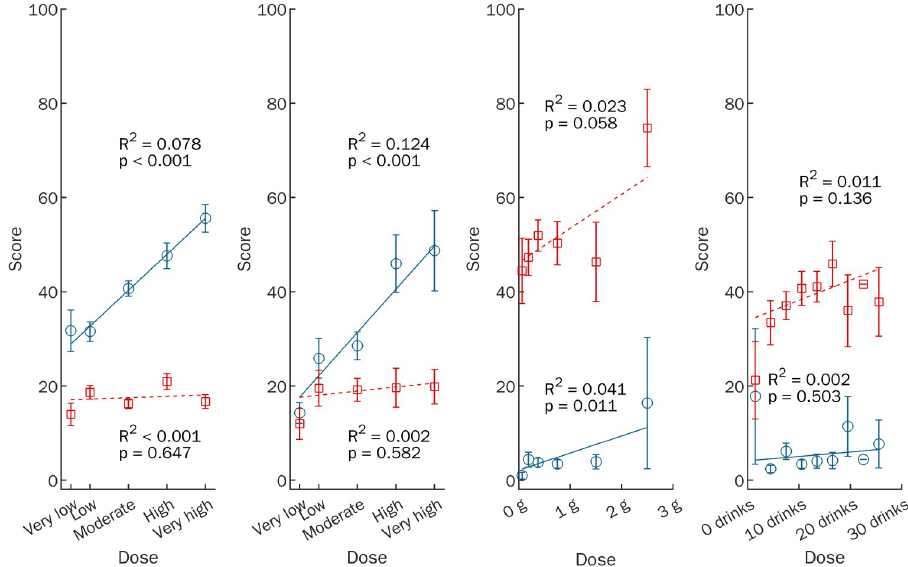
Fig 2. Relationship between ego-dissolution (blue circles, solid line) or ego-inflation (red squares, dashed line), respectively, and estimated dose for different drug experiences. The figure displays linear regression lines of best fit, the corresponding coefficient of determination and p-value as well as error bars ± 1 SEM and reproduces the results reported by Nour et al. [16] for (A) most intense hallucinogen experiences (n = 678), (B) typical hallucinogen experiences (n = 137), (C) cocaine experiences (n = 160), and (D) alcohol experiences (n = 204). Data of participants who did not estimate the dose taken were excluded from analysis.